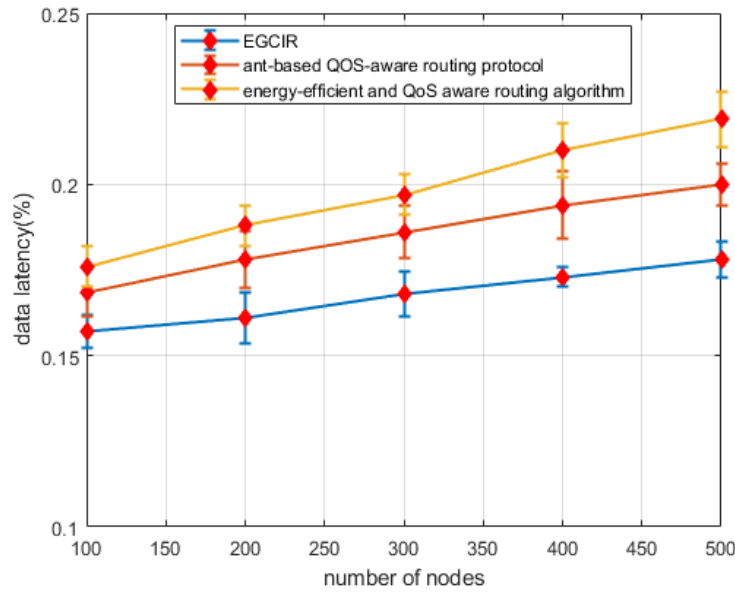
Figure 4. Impact of the nodes and data latency.